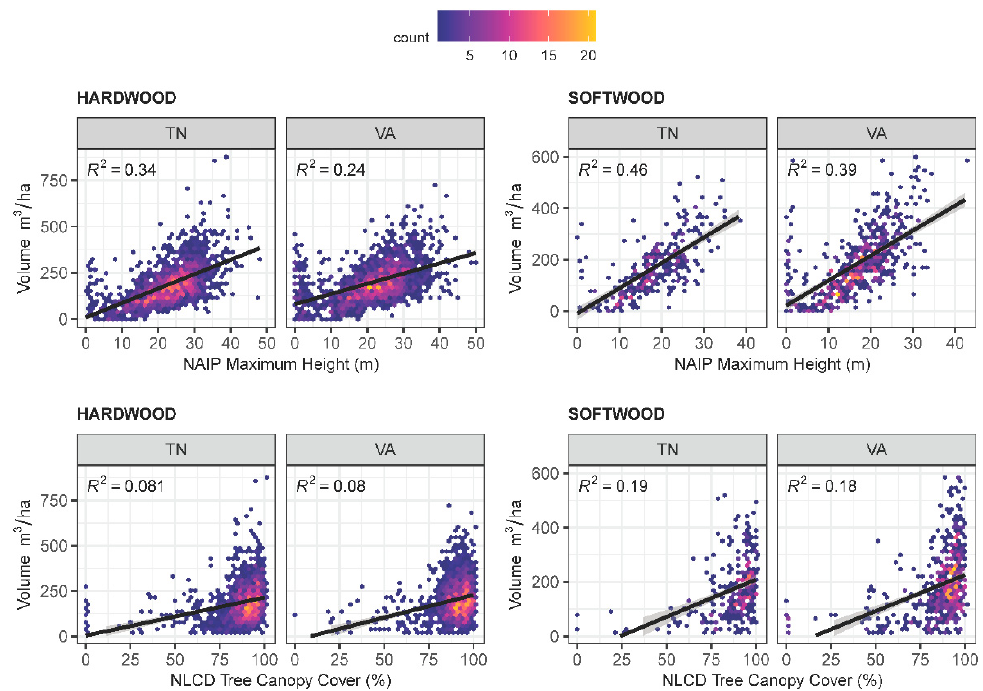
Figure 9. Scatter plots showing the relationship between NAIP maximum height (in meters, top row) and NLCD tree canopy cover (in %, bottom row) vs. FIA volume per area (m 3 /ha) for hardwood (left column) and softwood (right column) species groups.